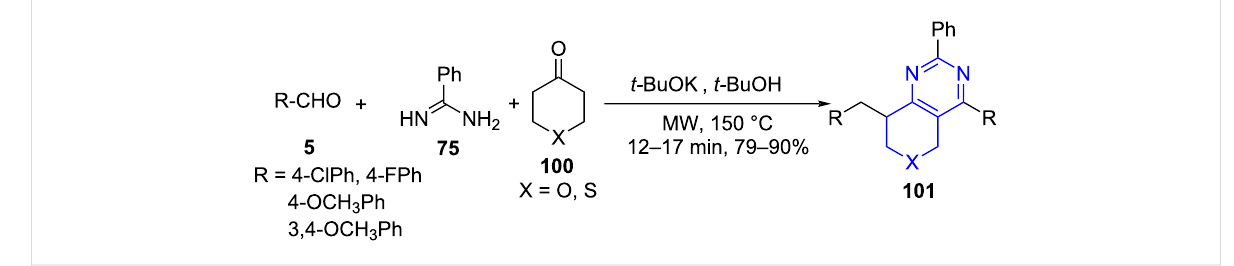
Scheme 38: Synthesis of thiopyrano[4,3- d